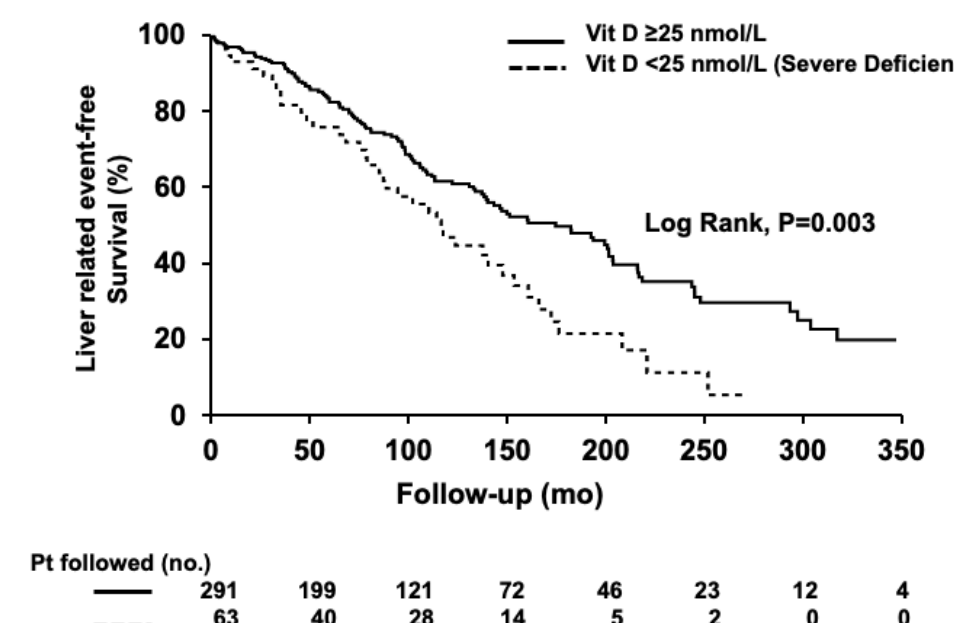
Figure 2. Liver-related event-free survival according to severe vitamin D deficiency status.